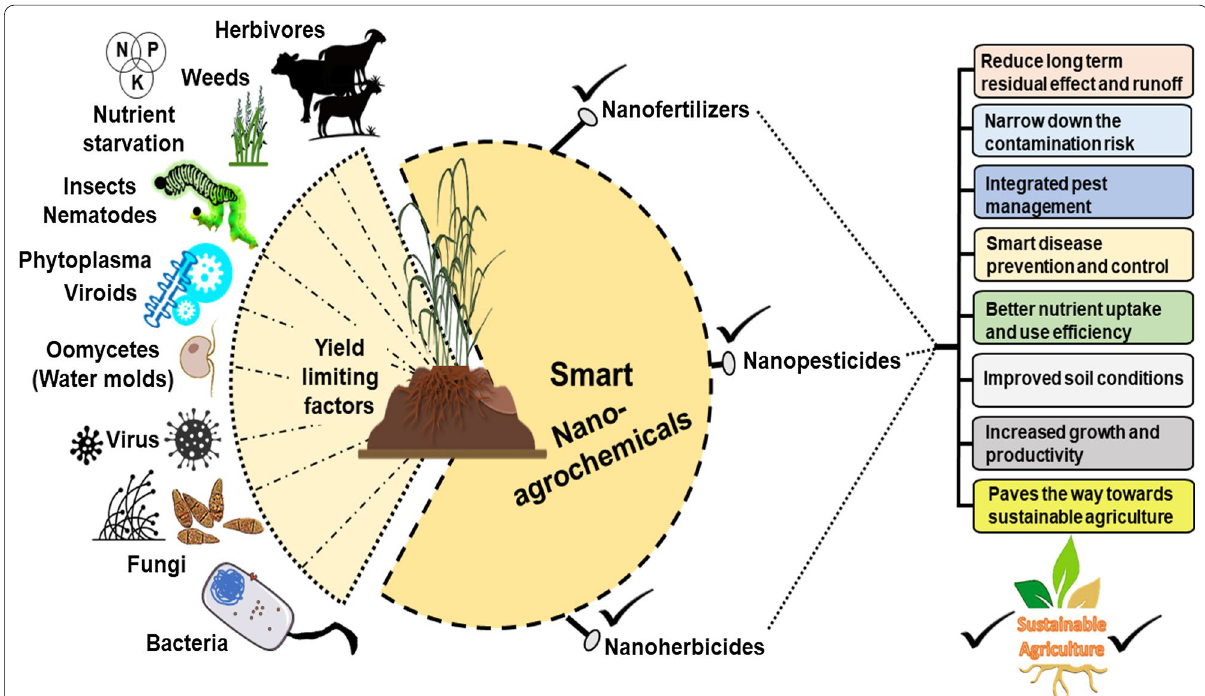
Fig. 3 Applications of different nanoparticles for regulation of plant growth, pathogen management, and nutrient uptake in sustainable